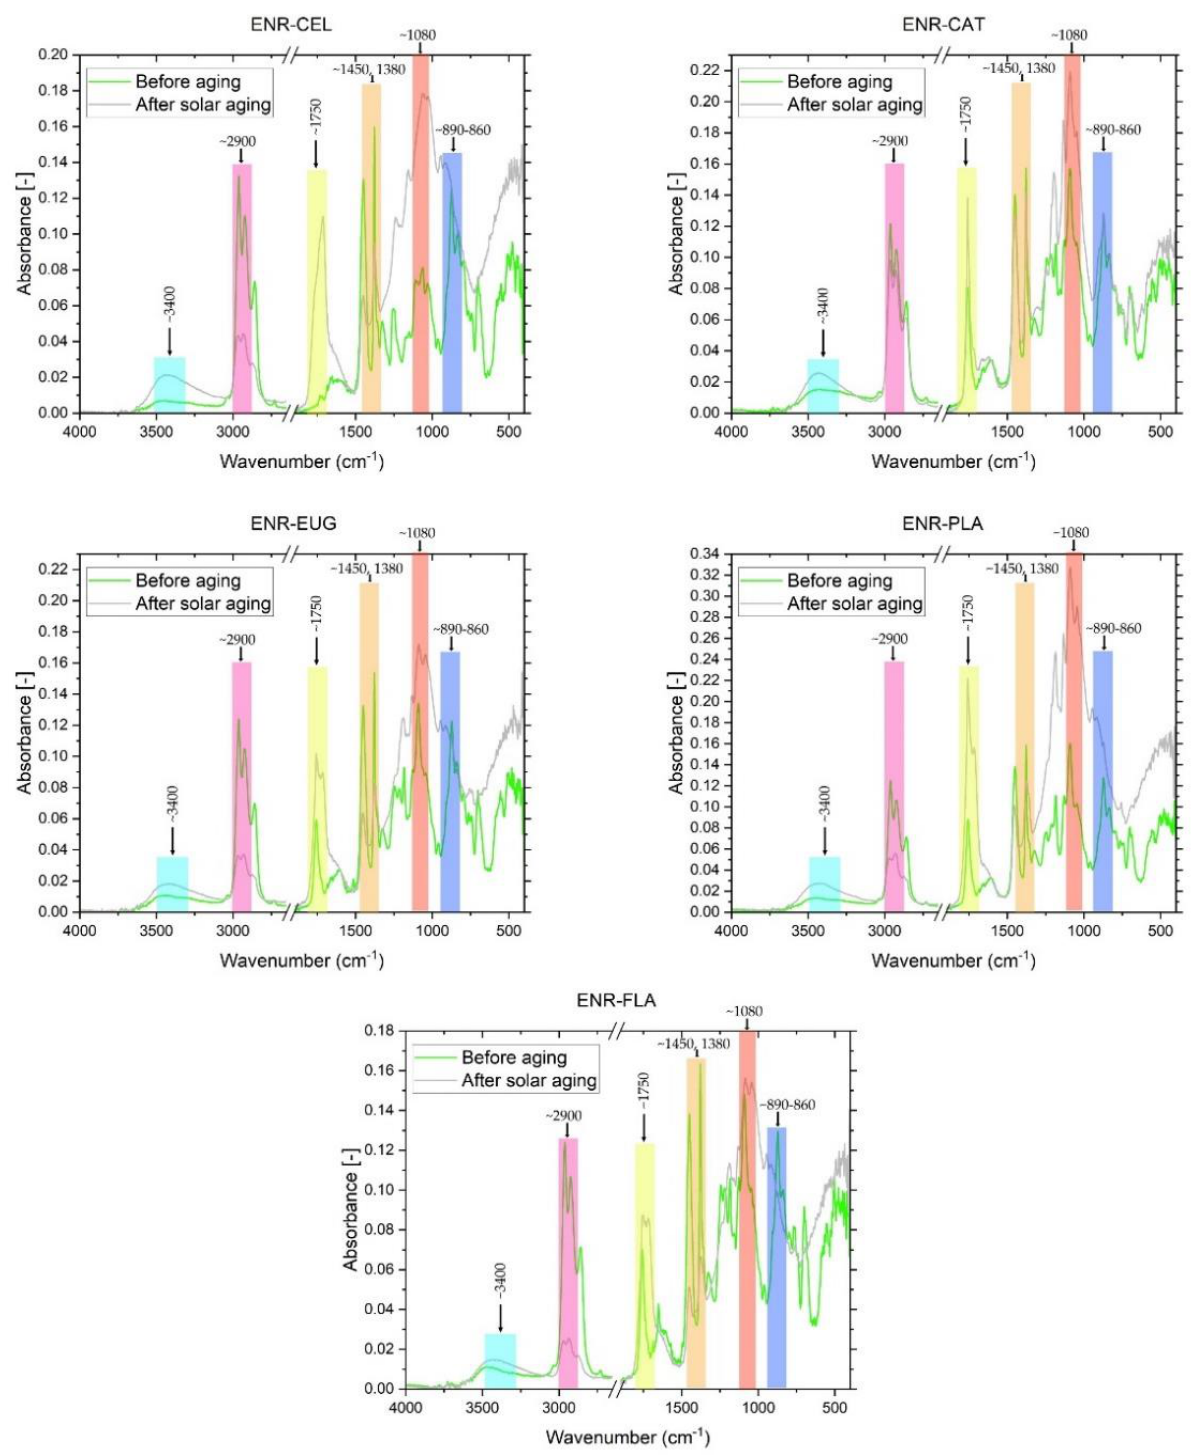
Figure 5. FT-IR spectra of ENR-50 blends with antioxidants before and after solar aging.